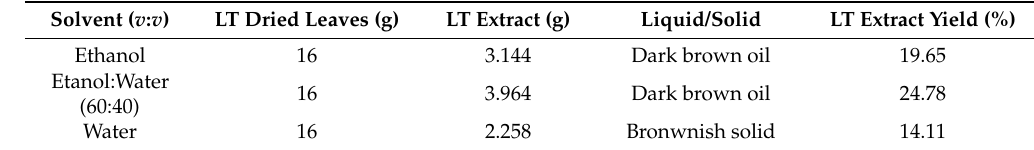
Table 1. Yield of the Larrea tridentata extract in various solvents.